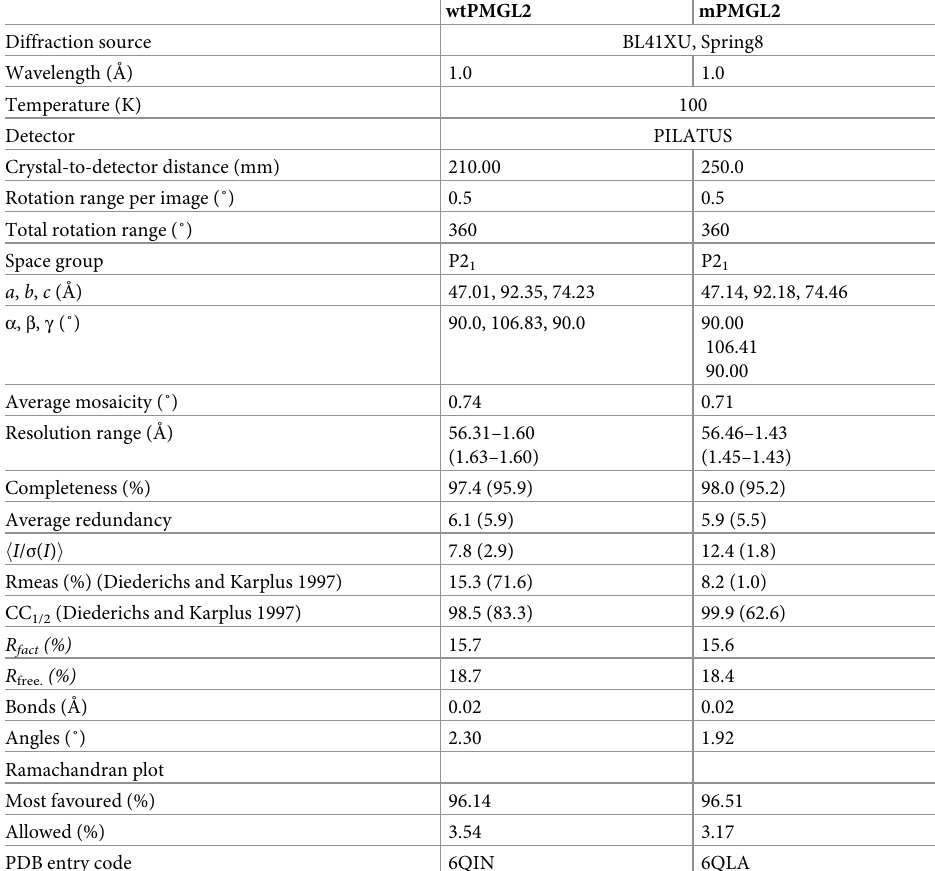
Table 1. Data collection, processing and